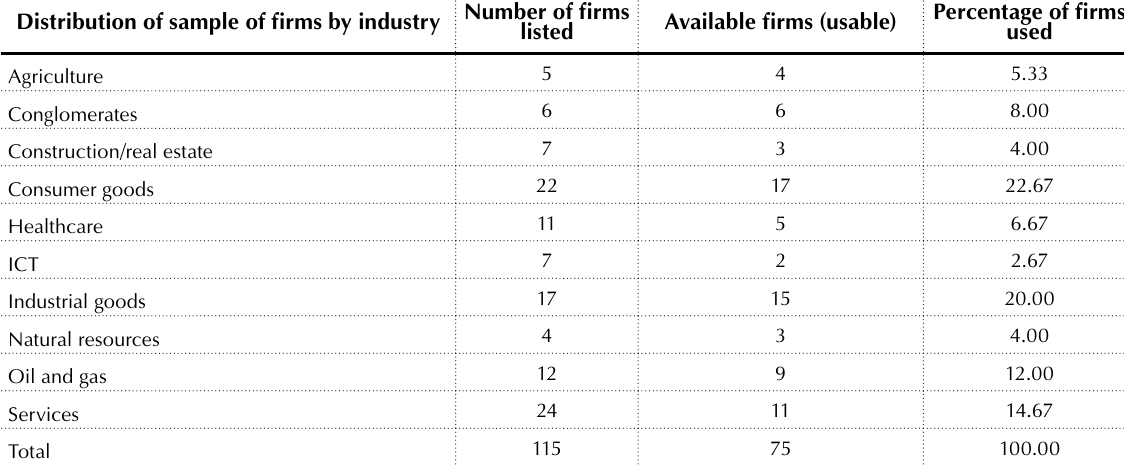
Source: Insight from the Nigerian Stock Exchange. Number of firms Available firms listed